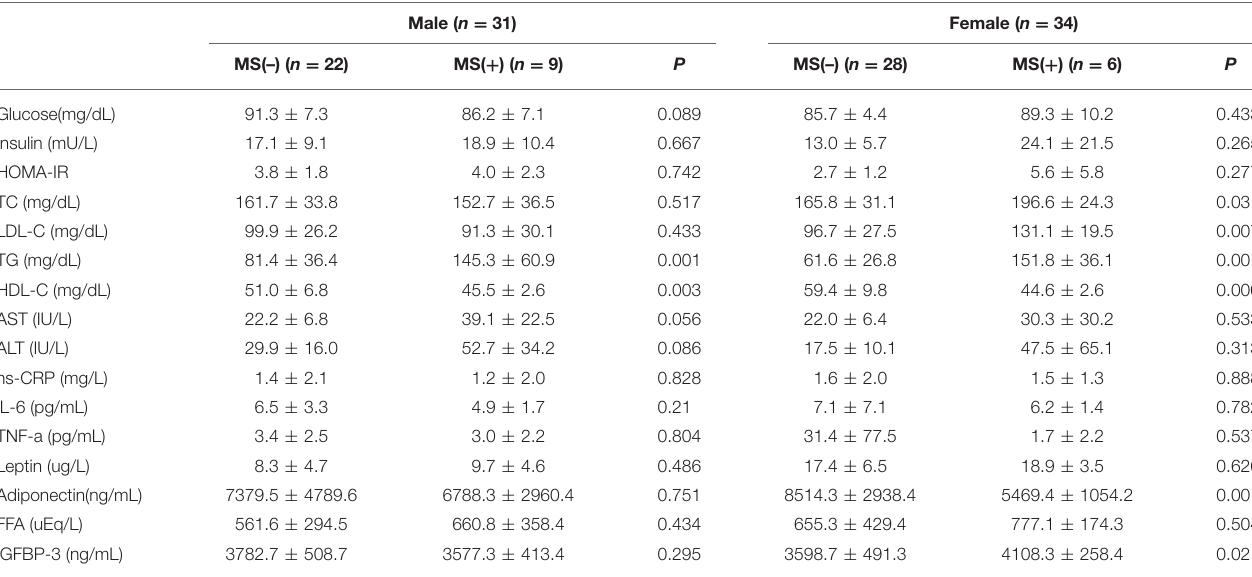
TABLE 3 | Comparison of biochemistry parameters in obese